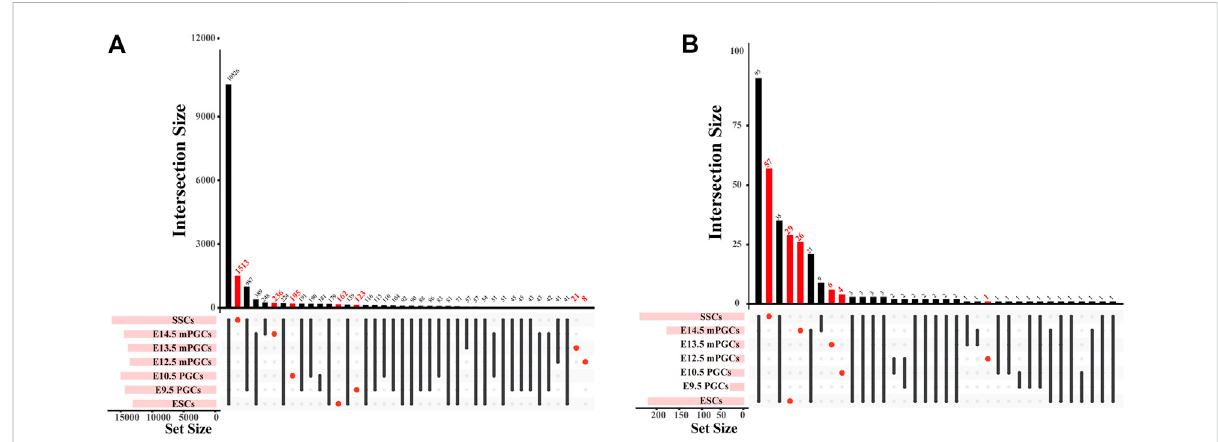
FIGURE 3 The number of cell-speci fi c genes and cell-speci fi c TFs in mouse ESCs, PGCs, and SSCs. (A,B) UpSet plot of cell-speci fi c genes (A) and cell- speci fi c TFs (B) .